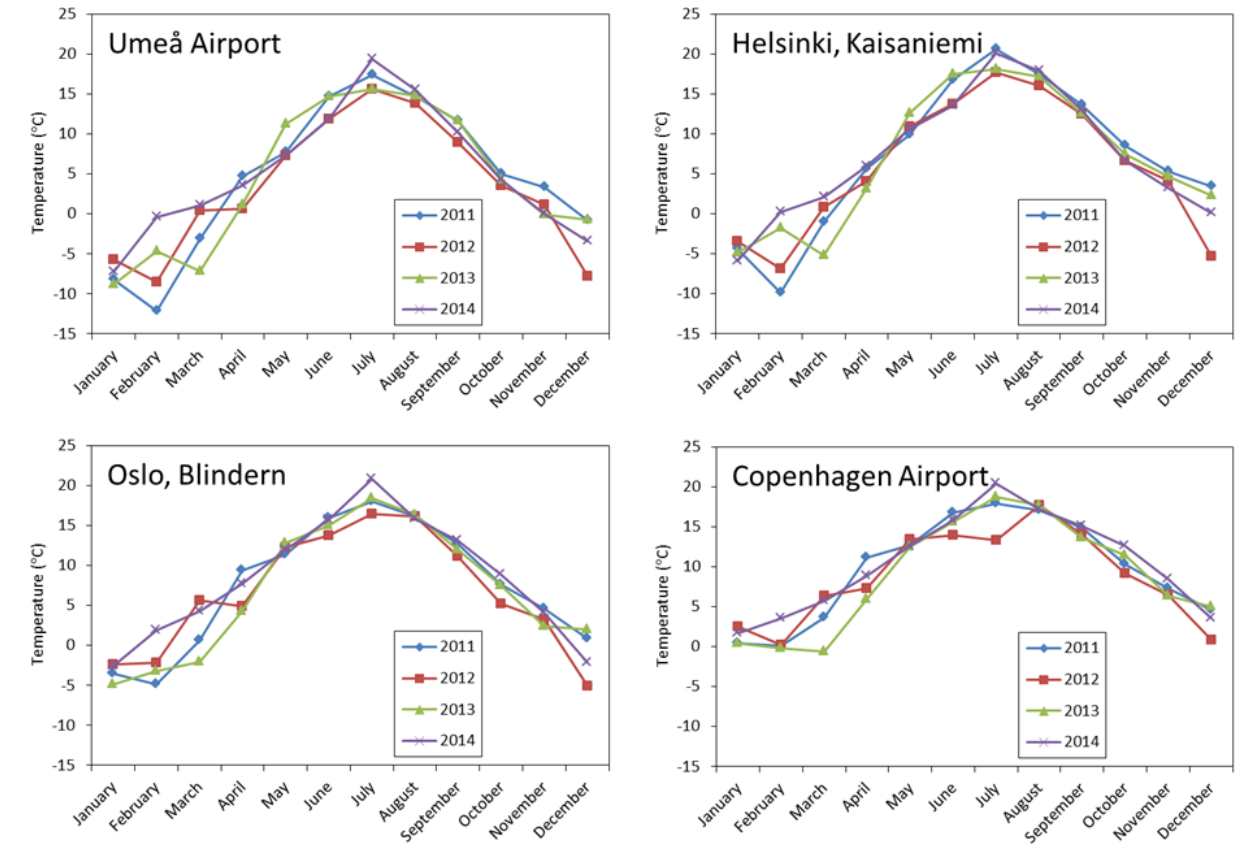
Figure D1. The monthly averaged values of the measured ambient temperatures in the four selected cities, for the years